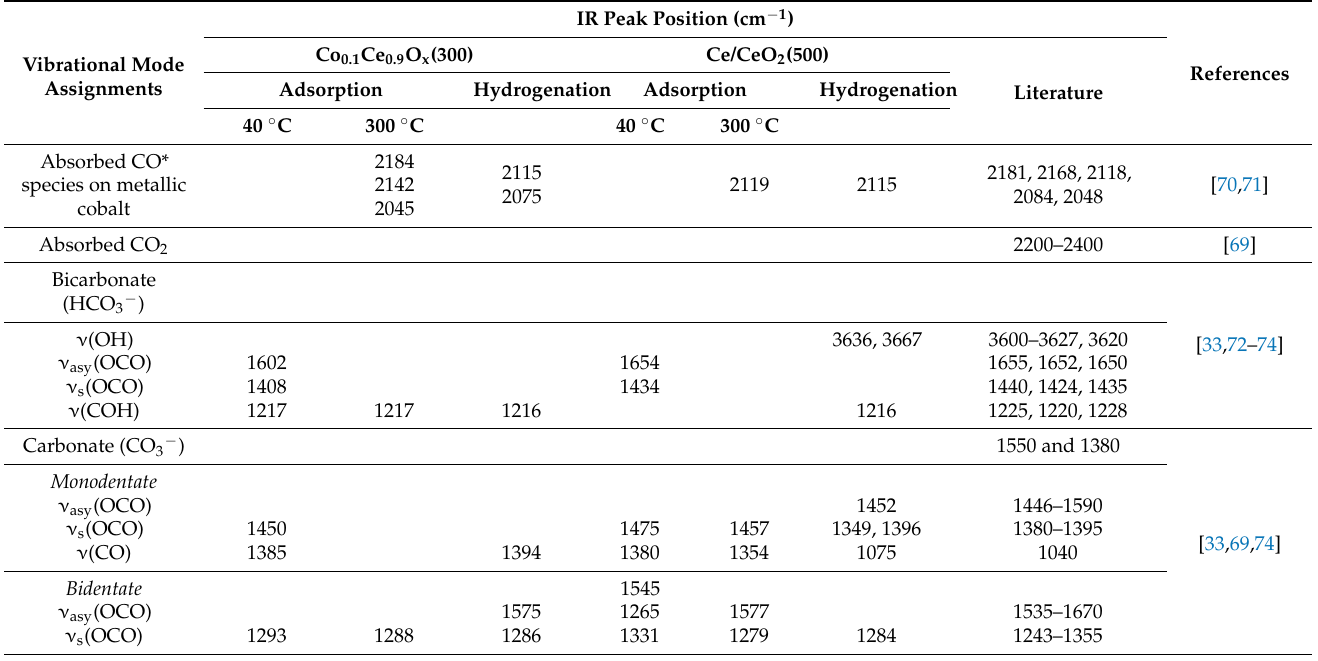
Table 2. FT-IR peaks during CO 2 adsorption and hydrogenation over Co 0.1 Ce 0.9 O x (300) and Co/CeO 2 (500).